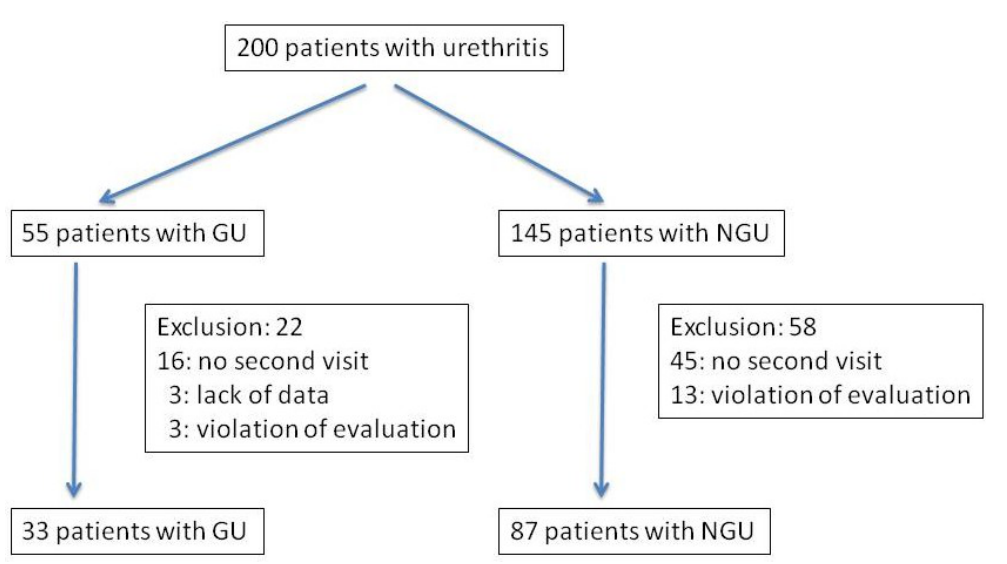
Figure 1. Flow chart for assessment of patients: gonococcal urethritis = GU, nongonococcal urethritis = NGU).